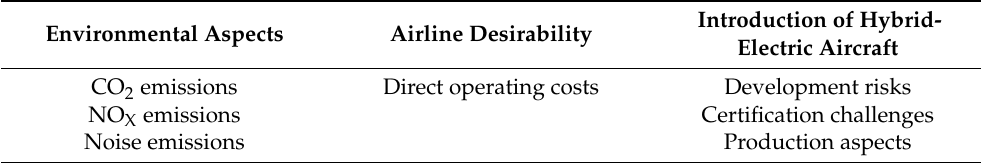
Table 6. Summary of figures of merit selected in the frame of F UT P R I NT